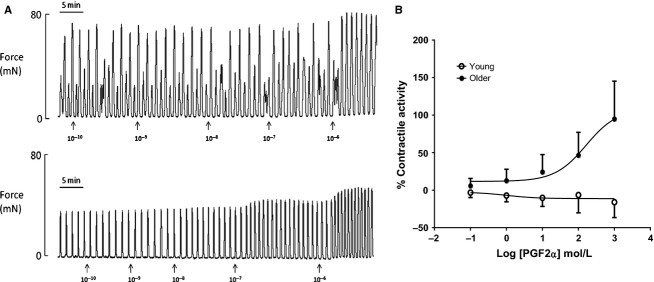
Stimulation of uterine contractile activity with PGF2α. (A) Representative recordings of stimulated uterine contractions in a YOUNG (top trace) and OLDER (bottom trace) rat dam by the accumulative addition of PGF2α (range 0.1 nmol/L to 1 μmL/L, units shown are in log mol/L). (B) A dose–response curve to determine the effects of maternal age (YOUNG (n = 4) or OLDER (n = 7) on uterine integral activity to increasing doses of PGF2α (range 0.1 nmol/L to 1 μmL/L, units shown are in log mol/L). Statistical analysis reveals that the dose–response curves were significantly different (P < 0.0005). LogEC50 was significantly shifted by maternal age, YOUNG logEC50 = 0.009, OLDER logEC50 =2.22.